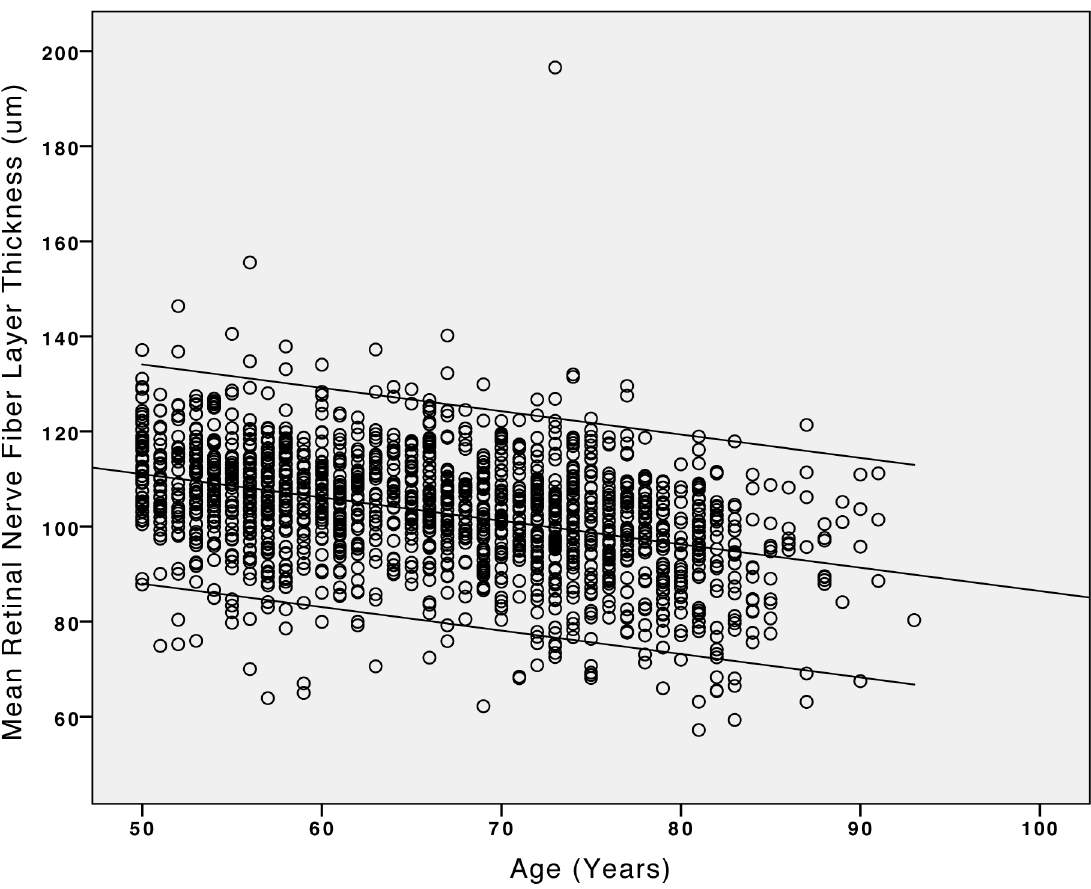
Figure 2. Scattergram showing the correlation (and 95% confidence interval of the regression line) between age and the mean retinal nerve fiber layer thickness measured by spectral domain optical coherence tomography (iVue SD-OCT) in the Beijing Eye Study 2011. diameters from 1.3 to 4.9 mm with 0.3 mm intervals and 12 radial